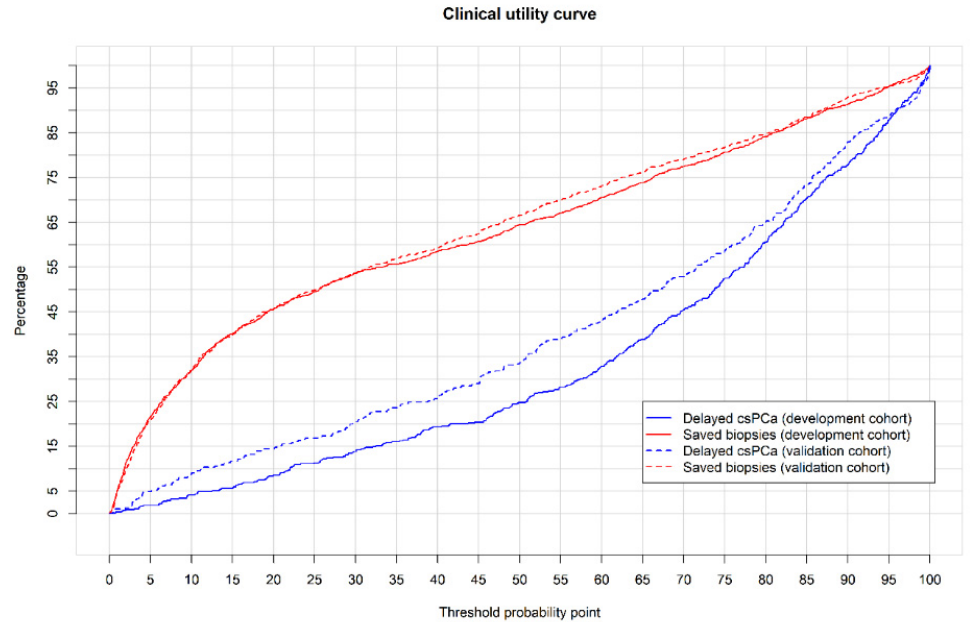
Figure 4. CUCs showing the rates of avoided biopsies (red lines) and corresponding missed csPCa (blue lines) regarding the continuous threshold of csPCa probability using MRI-PMs in development cohort (continuous lines) and external validation cohorts (interrupted lines).